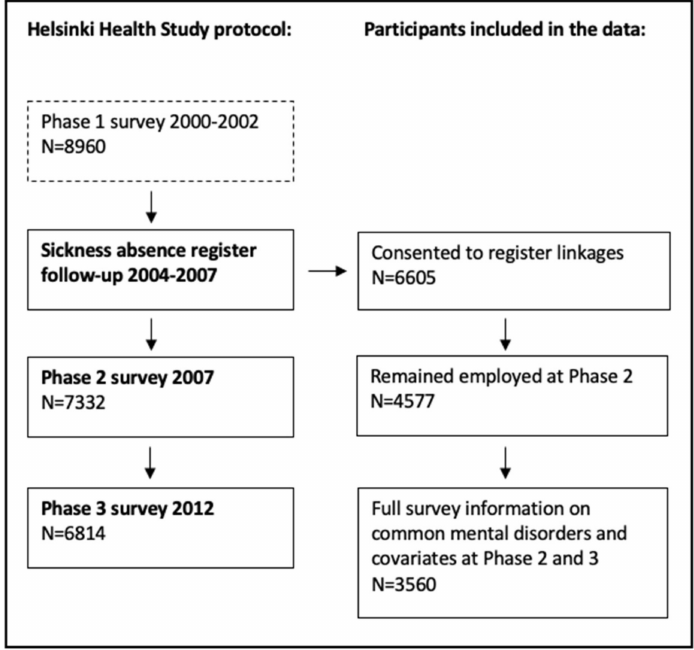
Figure 1. Flow chart of the